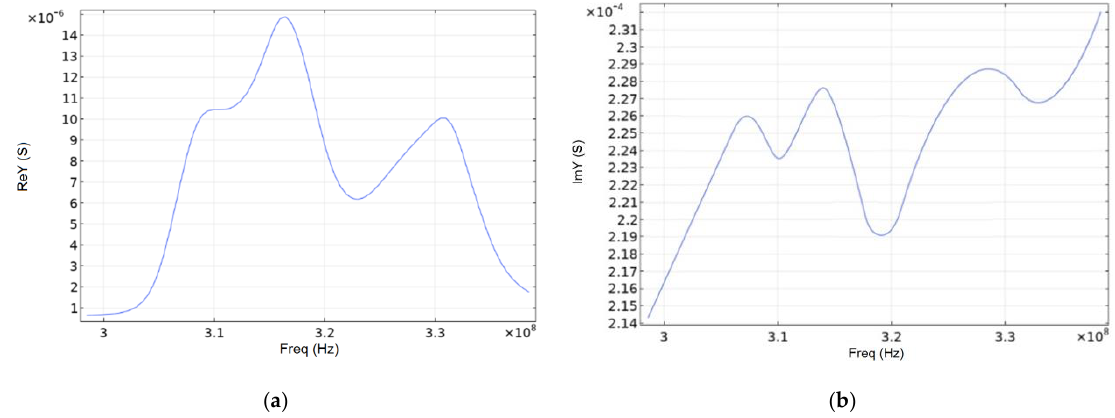
Figure 9. Real ( a ) and imaginary ( b ) admittance component for AlN.